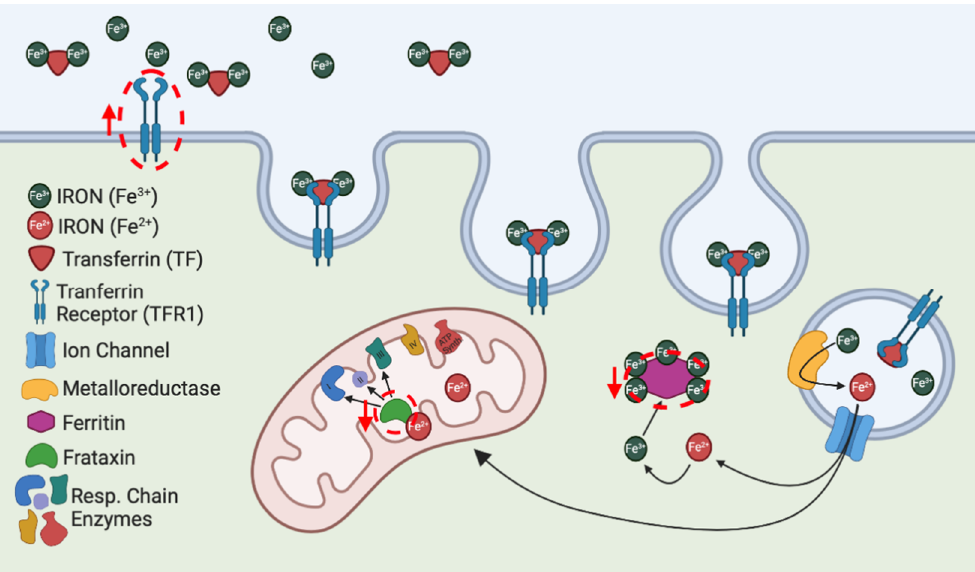
Figure 1. Iron metabolism and its relationship with ferroptosis. Through the transferrin receptor 1 (TFR1), the iron (Fe 3 + ) binds to the transferrin carrier (TF) and is imported into the cell by endocytosis. In the endocytic vesicle, Fe 3 + is reduced to Fe 2 + and released in the cytosol, where it is targeted to mitochondria for heme (not shown) and iron–sulfur cluster (ISC) synthesis. The intracellular iron excess is stored in ferritin complexes. The deregulation of red-circled proteins (i.e., TFR1, ferritin and frataxin) can trigger ferroptosis.